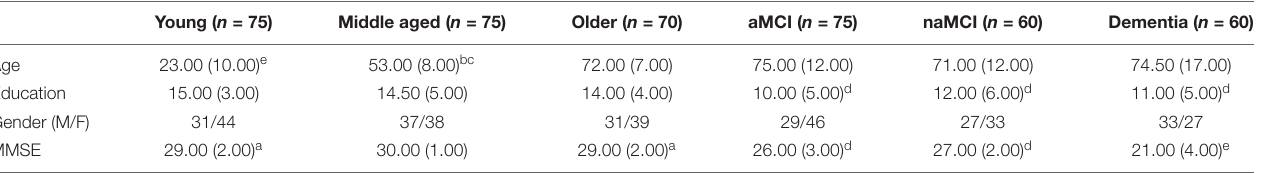
TABLE 1 | Median (and inter-quartile range) of demographics for participant